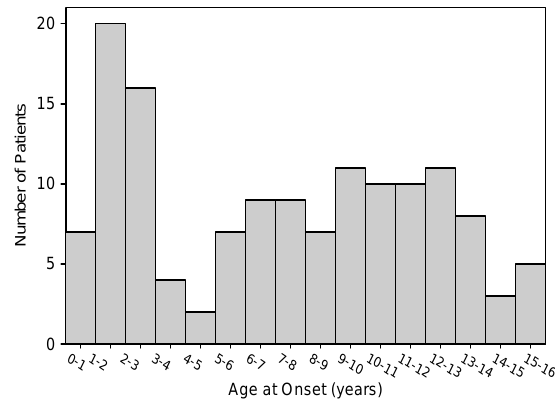
Figure 1. Age of onset of 139 children with JPsA diagnosed under the Vancouver criteria. Evaluation of multiple cutoffs between the younger and older distributions reveals optimal division at , 5 years vs. 5 years and above; the resulting two distributions do not deviate significantly from normal as assessed by the Lillefors-corrected Kolmogorov-Smirnoff test. Reprinted with permission (pending) from Stoll et al.